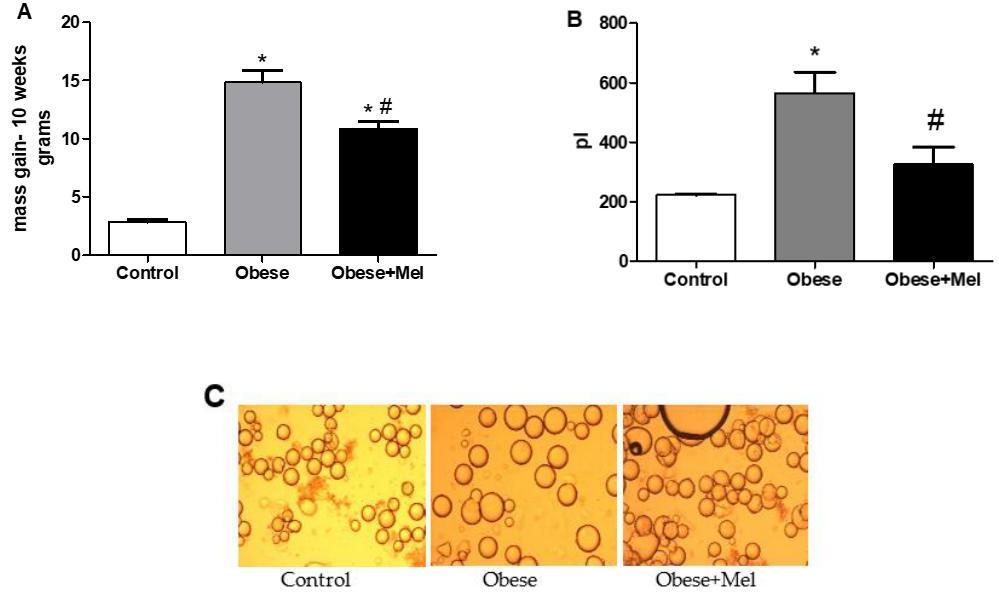
Figure 1. E ff ects of a high-fat diet (HFD) and melatonin supplementation (Mel, 1 mg / kg b.w., diluted in drinking water, daily, for 10 weeks) on body weight and adipocytes size. ( A ) Mice body mass gain at the end of experimental protocol. ( B ) Volume (in picoliters) of epididymal (EPI) isolated adipocytes. ( C ) Isolated EPI adipocytes photographed under optic microscope ( × 100 magnification). Adipocyte volume (4/3 × π × r 3 ) was determined by measuring 100 cells per animal (six fields for each slide). Results were analyzed by a one-way ANOVA and a Tukey post-test. Values are mean ± SEM (Control n = 21; Obese n = 17; Obese + Mel n = 20). * p < 0.05 vs. control; # p < 0.05 vs. obese.